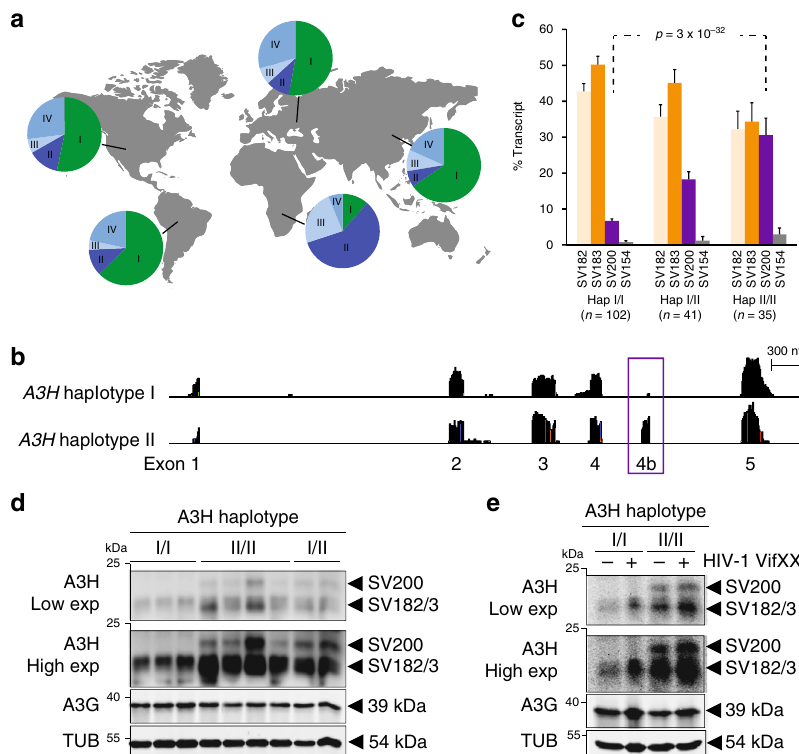
Fig. 2 Differential splicing and global distributions of A3H haplotypes I and II. a Pie charts representing the frequency of each major A3H haplotype within human populations in the indicated geographic regions. b Representative RNAseq pro fi les of LCLs derived from individuals homozygous for A3H haplotypes I or II with the exon 4b region boxed. c Bar charts reporting the average percentage of each splice variant observed in LCLs from donors with the indicated A3H genotype ( n values are shown and error bars represent 95% CI, p value is calculated using two-tailed Student ’ s t -test). d , e Immunoblots of whole-cell extracts derived from LCL ( d ) or PBMC ( e ) with the indicated A 3H haplotypes. PBMC were mock-treated or infected by Vif-de fi cient HIV-1 to induce A3H gene expression. Low and high exposures are shown for anti-A3H blots to show SV200 speci fi city to the haplotype II genotype. Anti-A3G and anti- TUBULIN (TUB) blots are shown as